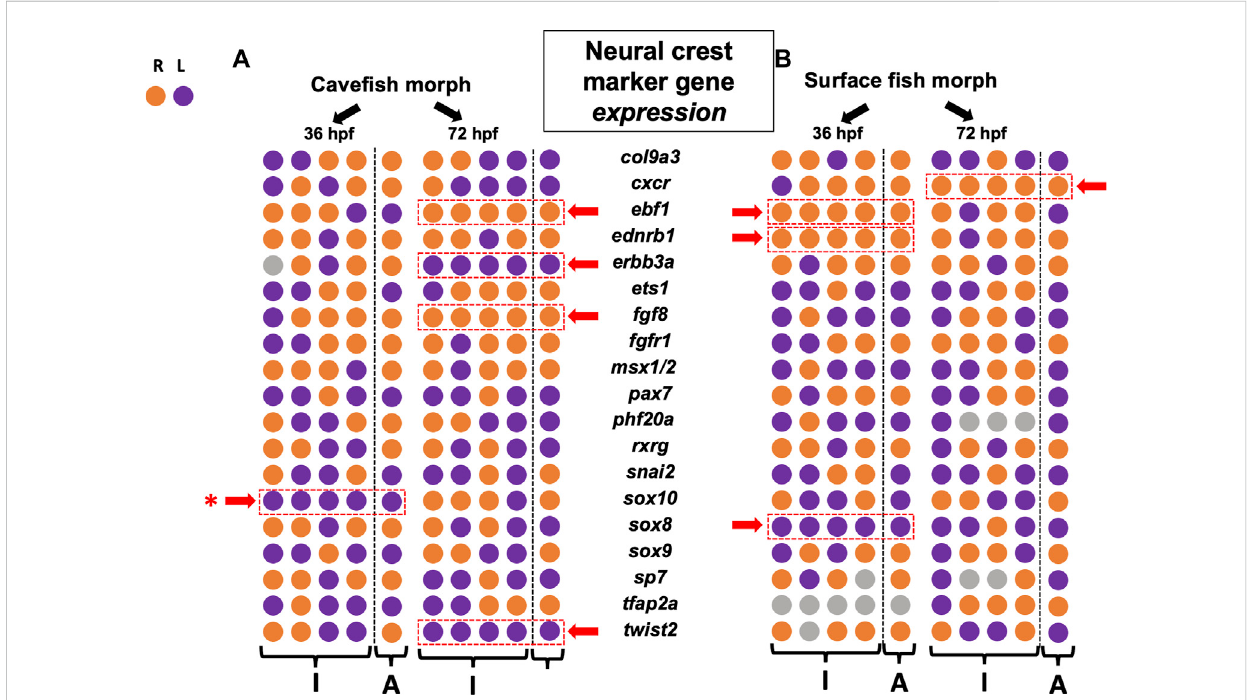
FIGURE 3 Asymmetry measures for gene expression level across the left-right axis reveals diverse patterns of lateralization in cave and surface morphs. 19 neural crest genes are arrayed for cave fi sh (A) and surface fi sh (B) at 36 hpf and 72 hpf. Individual ( “ I ” ) and aggregate ( “ A ” ) polarities reveal more examples of consistent asymmetry at later stages for cave fi sh, but more examples at earlier stages for surface fi sh. Five genes demonstrate consistent asymmetric polarity in cave fi sh (dashed red rectangle, red arrow), but the polarities were mixed (i.e., three leftward, two rightward). Similarly, four genes show consistent asymmetric polarity in surface fi sh (dashed red rectangle, red arrow), but again polarities were mixed (i.e., one leftward, three rightward). Overall, this analysis reveals common left-right variation between morphs. Note that the gene sox10 harbors consistent leftward bias in both expression area (Figure 2) and expression level (red